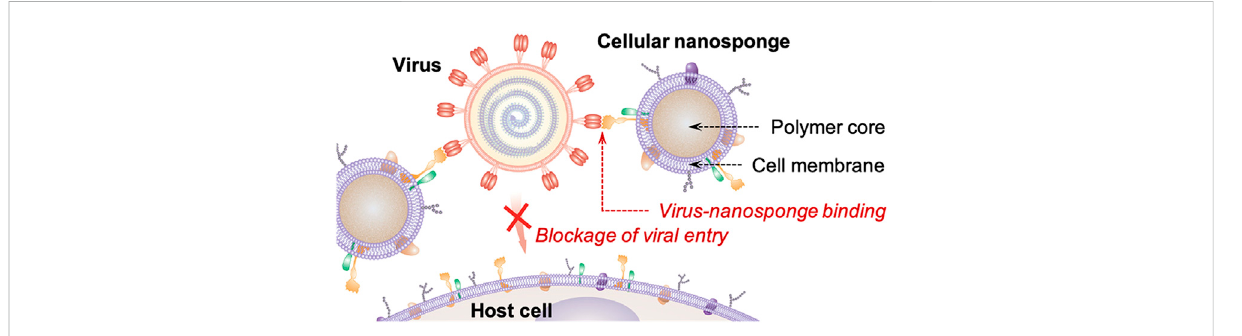
FIGURE 5 Depiction of nanosponges mimicking the target cell (host cell) membranes consisting of similar receptors (CD147 and ACE2). This inhibits the interactionoftheviruswiththehostcellresultingintheblockageofviralentryintothehostcell.Thisimageisadaptedfrom(Zhangetal.,2020)under theACSAuthor ’ sChoiceusageagreement.Thisisanunof fi cialadaptationofanimagethatappearedinanACSpublication.ACShasnotendorsedthe content of this adaptation or the context of its